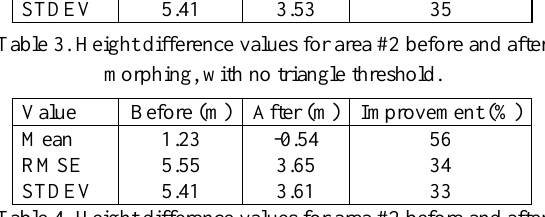
Table 4. Height difference values for area #2 before and after morphing, with triangle